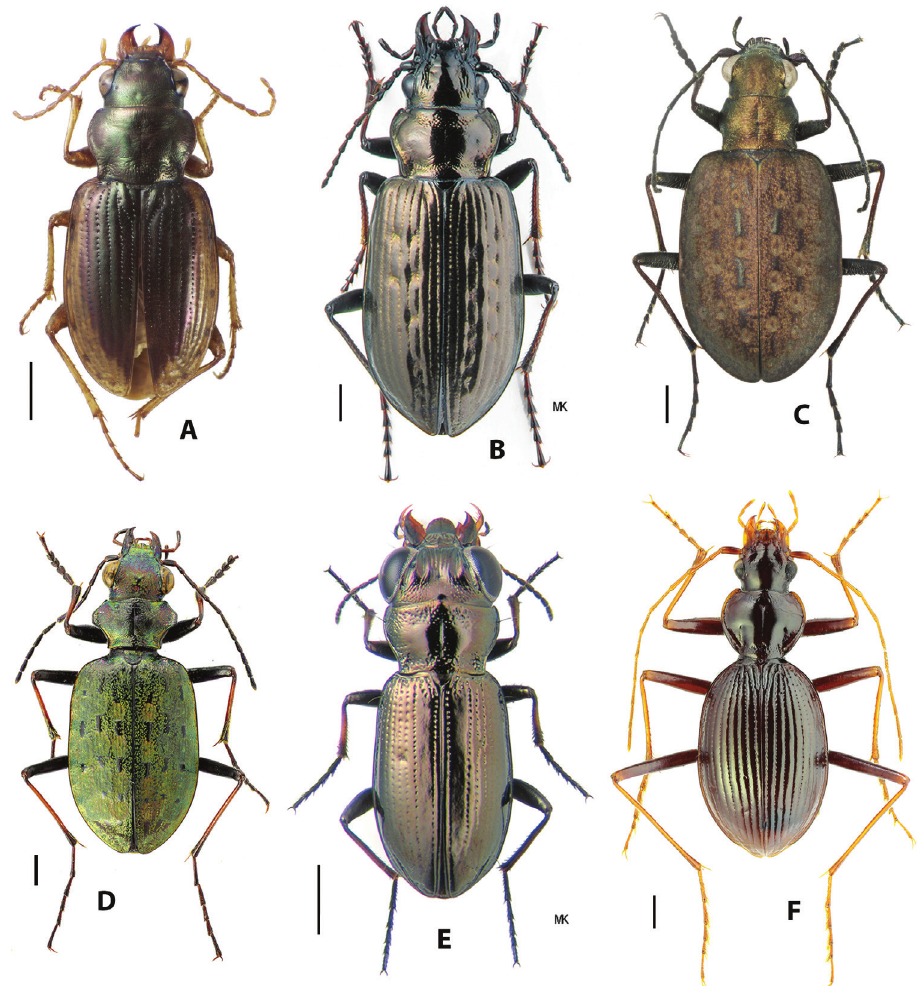
Figure 1. Habitus images of Nebriitae A Notiokasis chaudoiri Kavanaugh & Nègre B Pelophila borealis (Paykull) C Opisthius richardsoni Kirby D Paropisthius indicus chinensis Bousquet & Smetana E Notiophilus palustris Duftschmid F Archileistobrius hwangtienyuni Shilenkov & Kryzhanovskij. Scale bars: 1.0 mm. Photograph credits: A, C David Maddison; B, E Kiril Makarov; D, F Alexander